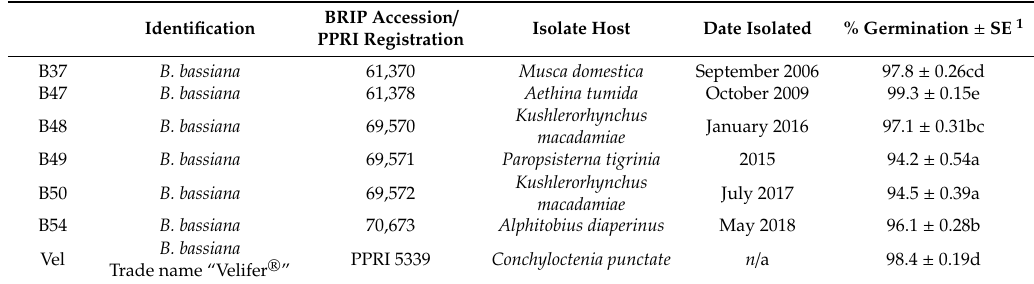
Table 1. Details of isolates of Beauveria bassiana screened against Carpophilus